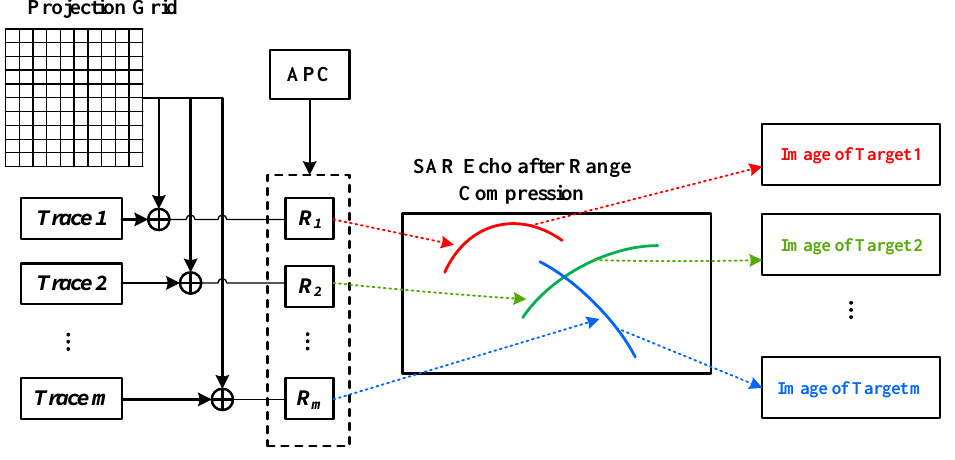
Figure 6. Flow chart of the moving target back-projection (m-BP)